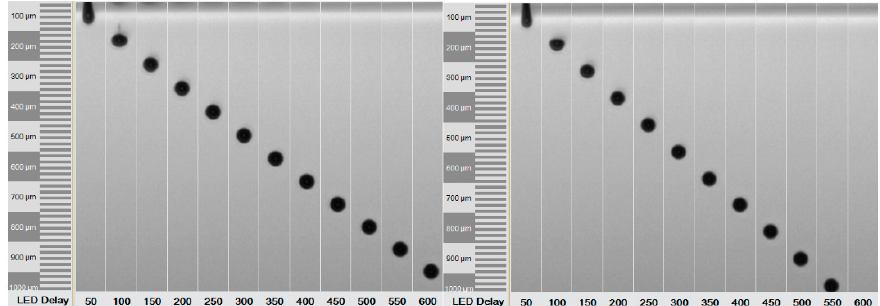
Figure 2. Droplet ejection and formation of the solvents (MQ/PG) Z = 7.6 and 1 mg/mL nanosuspension (MSN–PEI–F15) Z = 7.8 monitored at 1600 Hz from the 50 µm Ø nozzle. The captures show the time (LED delay, µs, X-axis) vs the travel distance (µm, Y-axis) of the recorded droplet ejection.